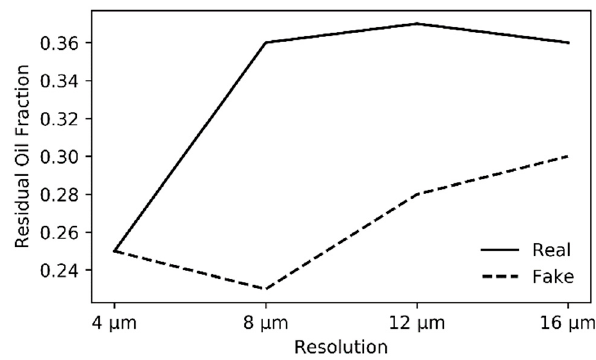
Figure 12. Resolution influence residual oil fraction after waterflooding, studied for mechanical (real) and artificial (fake) resolution reduction.